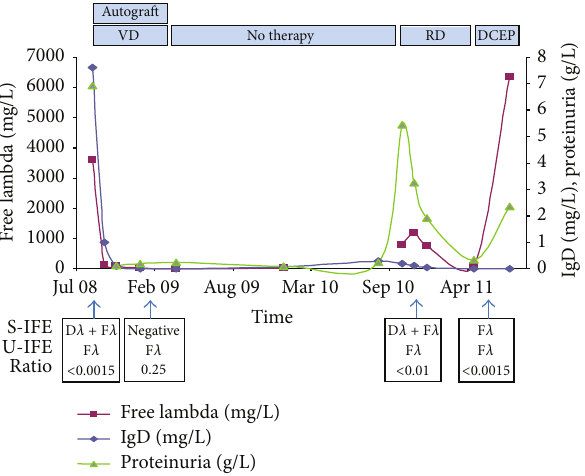
Figure 1: Graph shows the evolution of IgD, lambda-free light- chains, and proteinuria. The different treatments appear at the top (blue rectangles) and the results of IFE below the graph. S-IFE: serum immunofixation electrophoresis, U-IFE: urinary immunofix- ation electrophoresis, VD: velcade dexamethasone, RD: revlimid dexamethasone, and DCEP: dexamethasone cyclophosphamide etoposide